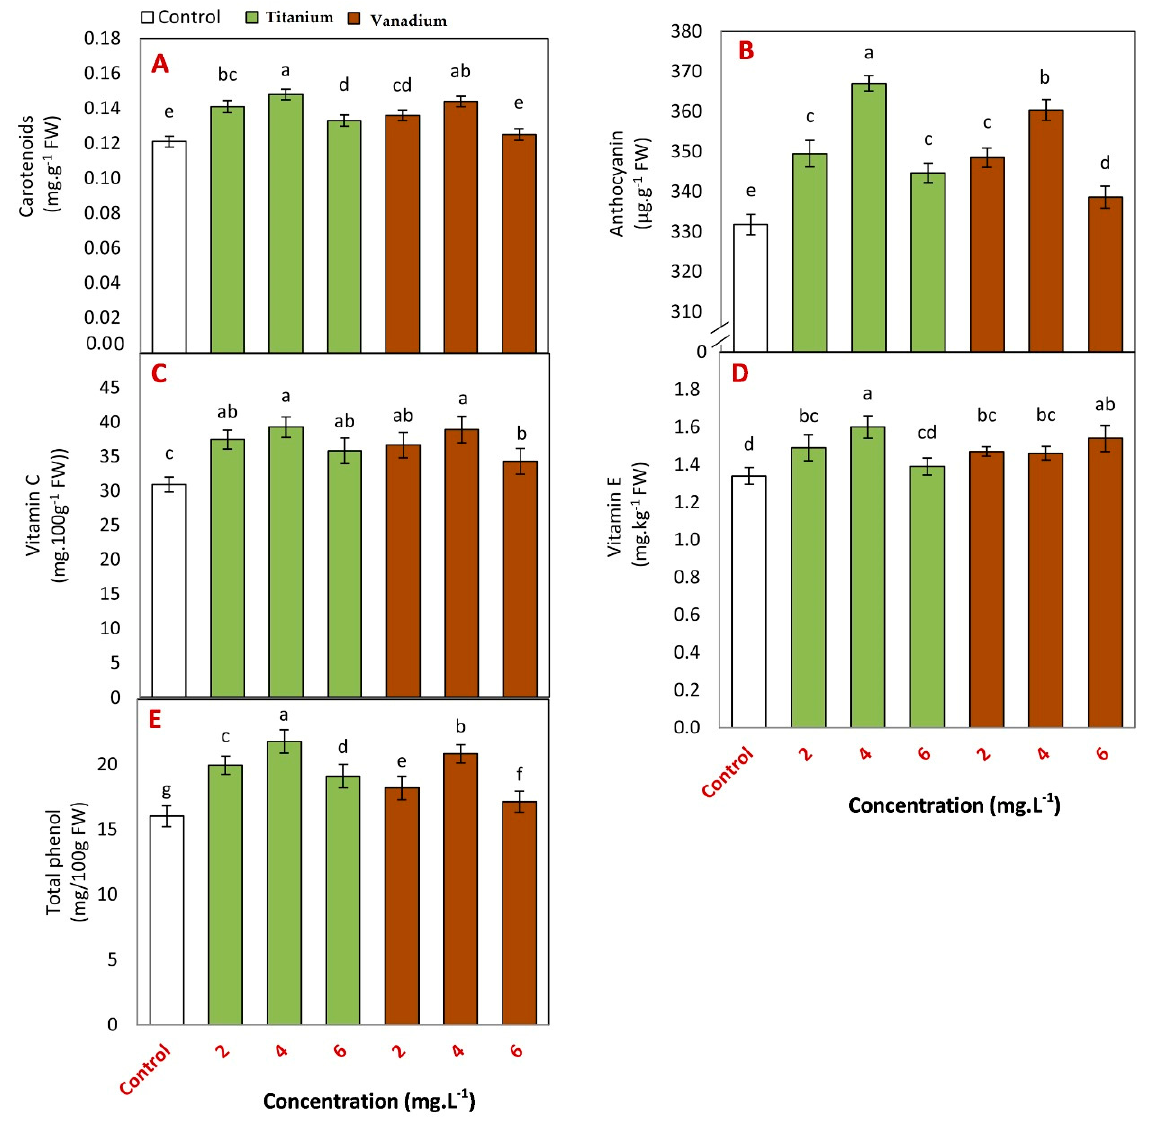
Figure 3. Contents of carotenoids ( A ); anthocyanin ( B ); Vitamin C ( C ); vitamin E ( D ); and total phenols ( E ) in red cabbage leaves as affected by foliar applications with Ti and V. The mean values followed by different letter are significantly different at p < 0.05 according to the Duncan test ( n = 3).